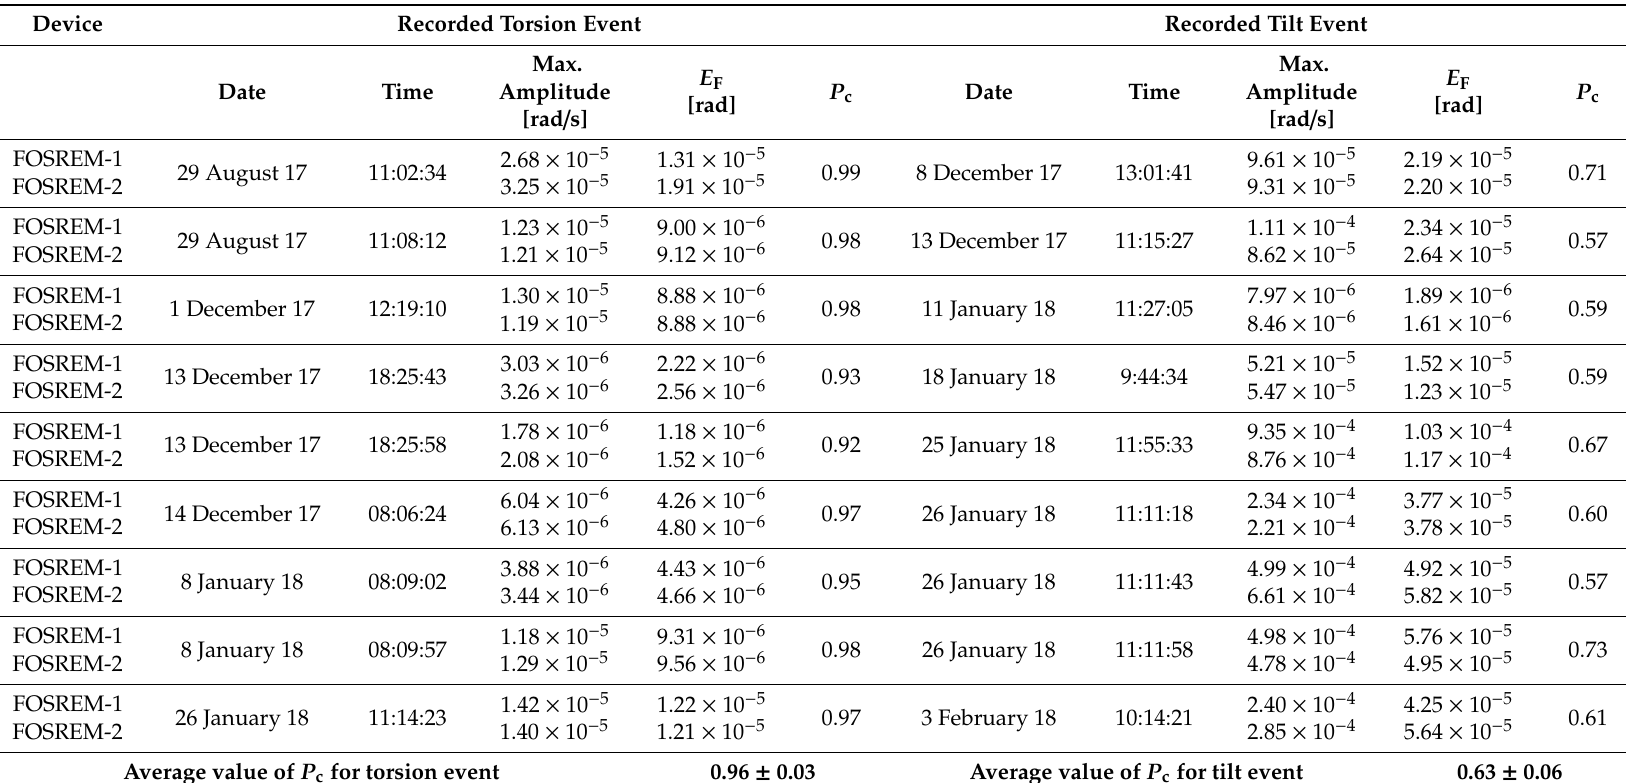
Table 2. Data recorded by the FOSREMs in the geophysical observatory in Ksi ˛a˙z, Poland in a period of 29 August 2017–3 February 2018.